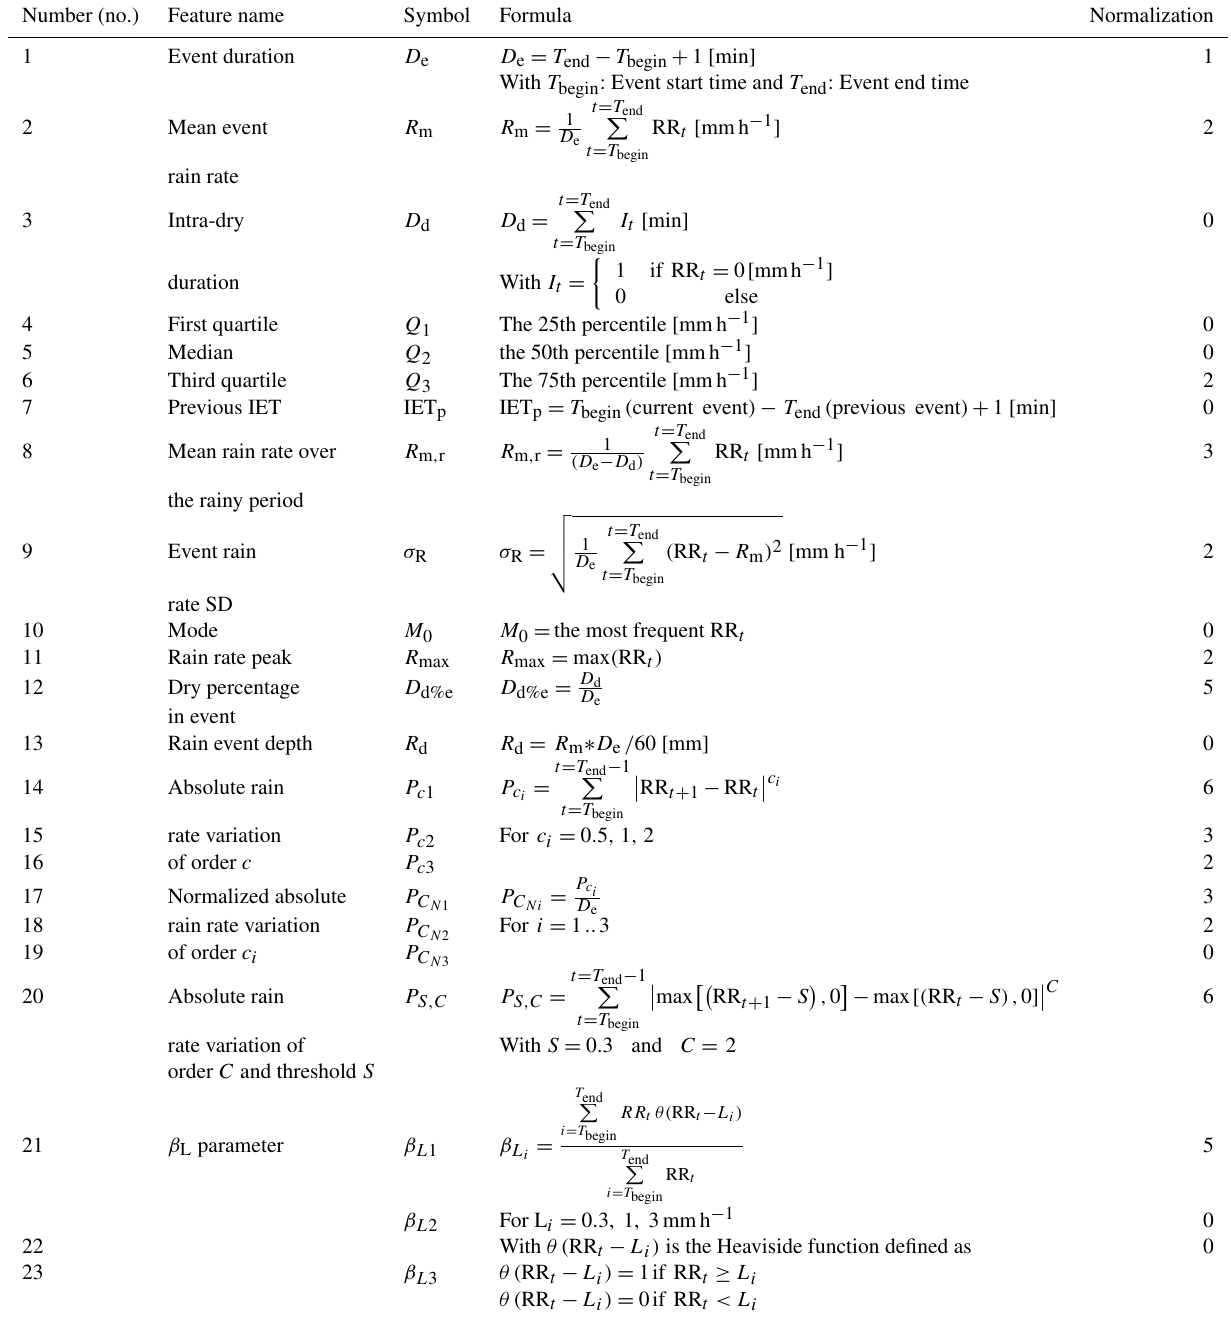
Table 2. The 23 variables identified in the literature, used for the characterization of rain events. Number